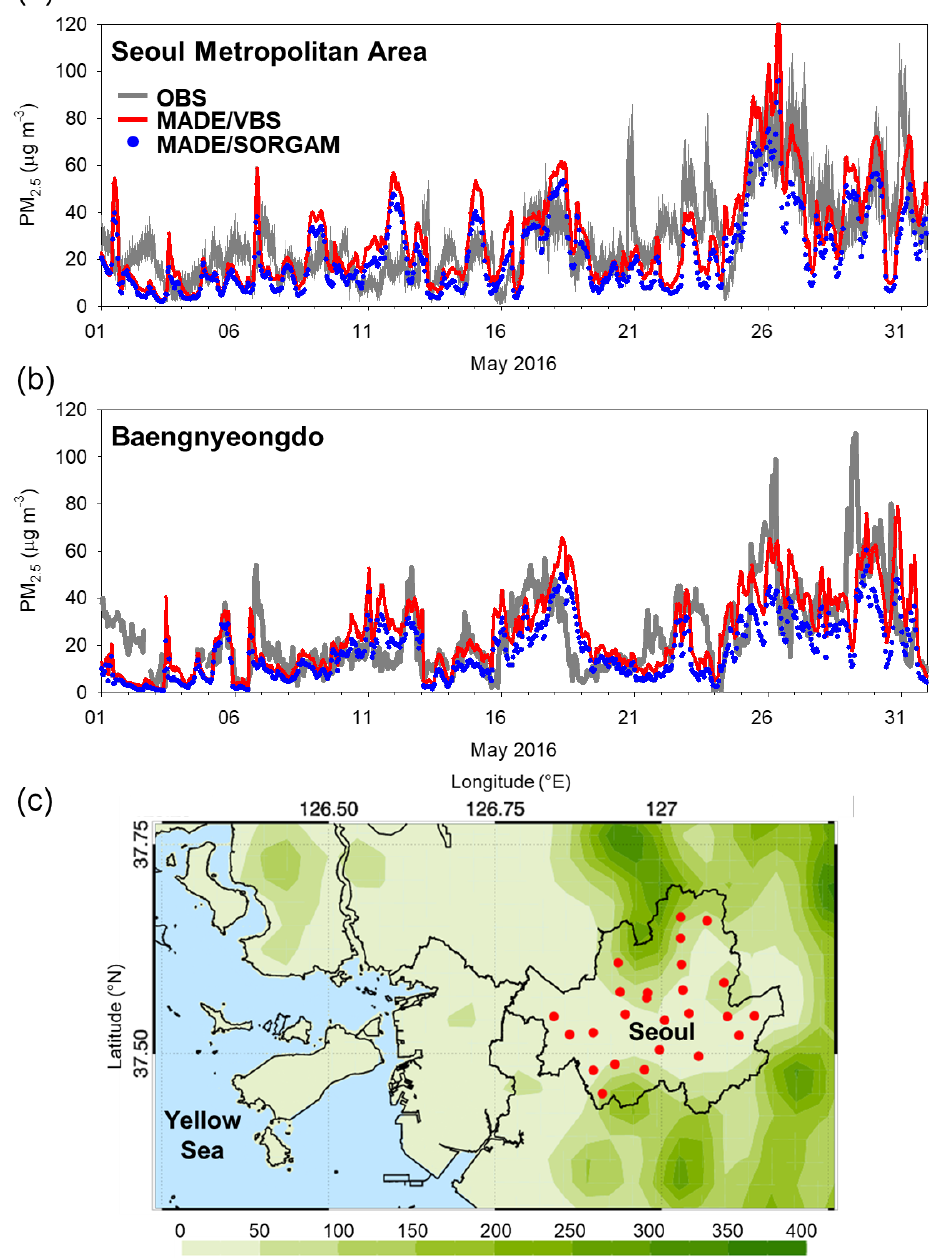
Figure 2. Time series of hourly mean PM 2.5 concentrations observed in ( a ) 25 urban sites located within Seoul metropolitan area (SMA) and ( b ) Baengnyeongdo (background) site in South Korea. The locations of these 25 sites over SMA are shown in ( c ). The 25 and 75 percentiles are denoted as grey in SMA. Modeling results in ( a , b ) from two modules, Modal Aerosol Dynamics model for Europe / Volatility Basis Set (MADE / VBS) and Modal Aerosol Dynamics model for Europe / Secondary Organic Aerosol Model (MADE / SORGAM), were also denoted in red and blue, respectively.